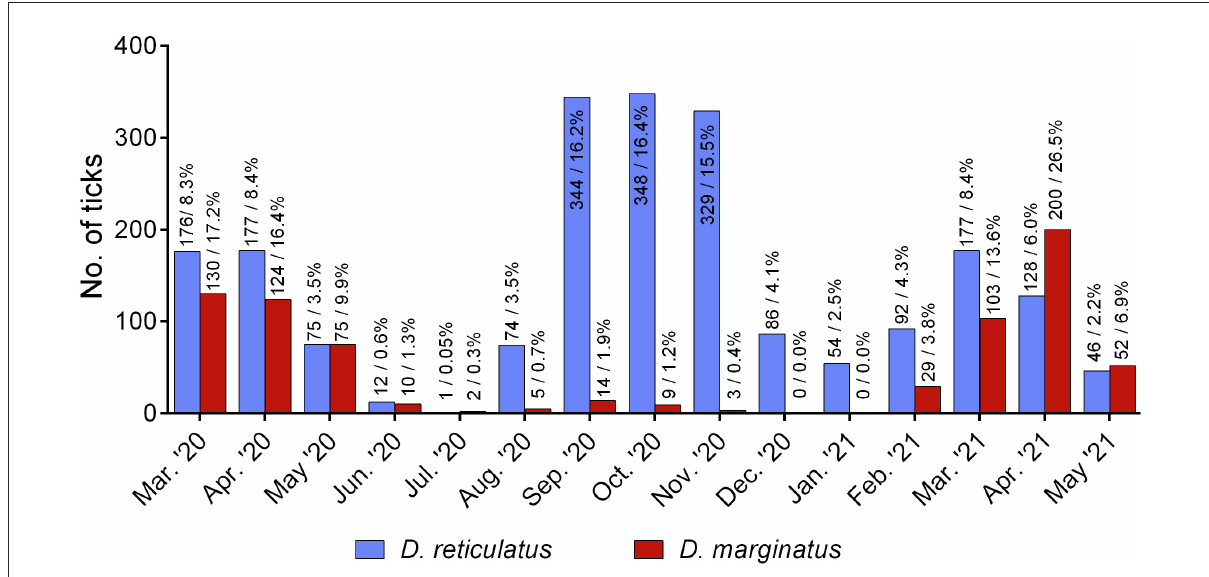
FIGURE4 D. reticulatus ( N = 2,119) and D. marginatus ( N = 756) specimens by month of collection, sent in by German citizens from March 2020 to May